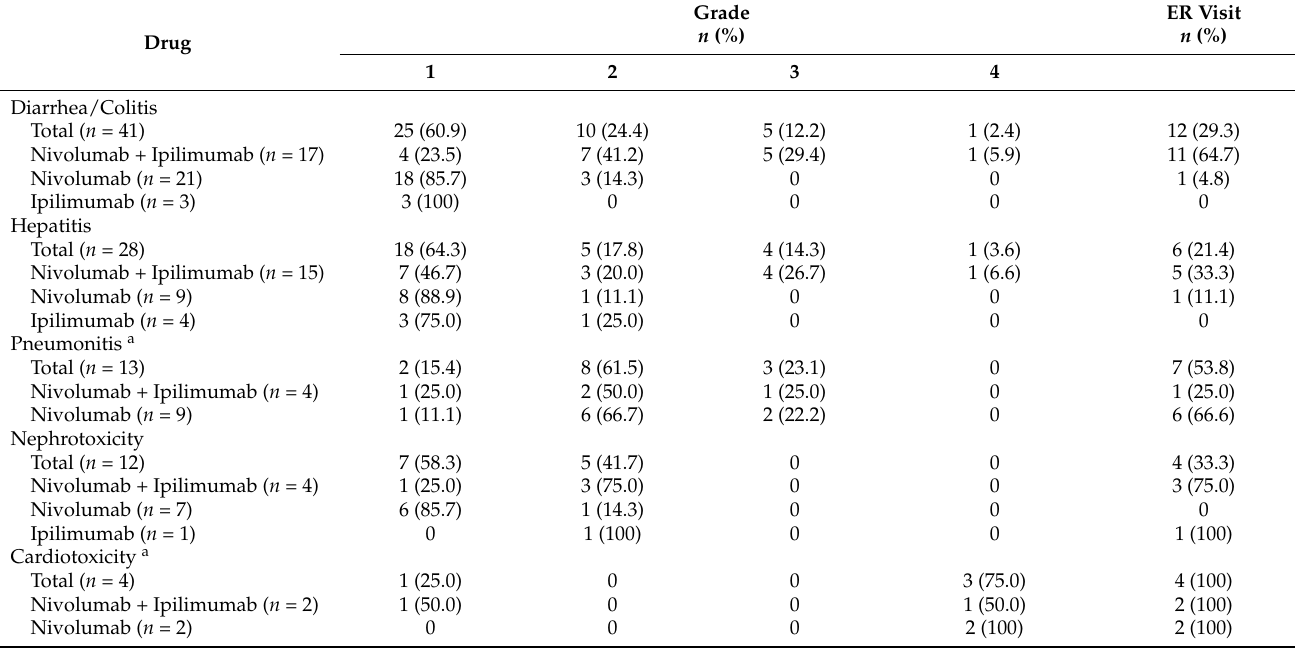
Table 3. New immune-related adverse events in Nova Scotia Health-Central Zone patients receiving nivolumab plus ipilimumab, nivolumab, or ipilimumab, categorized by organ system, toxicity grade, and emergency room